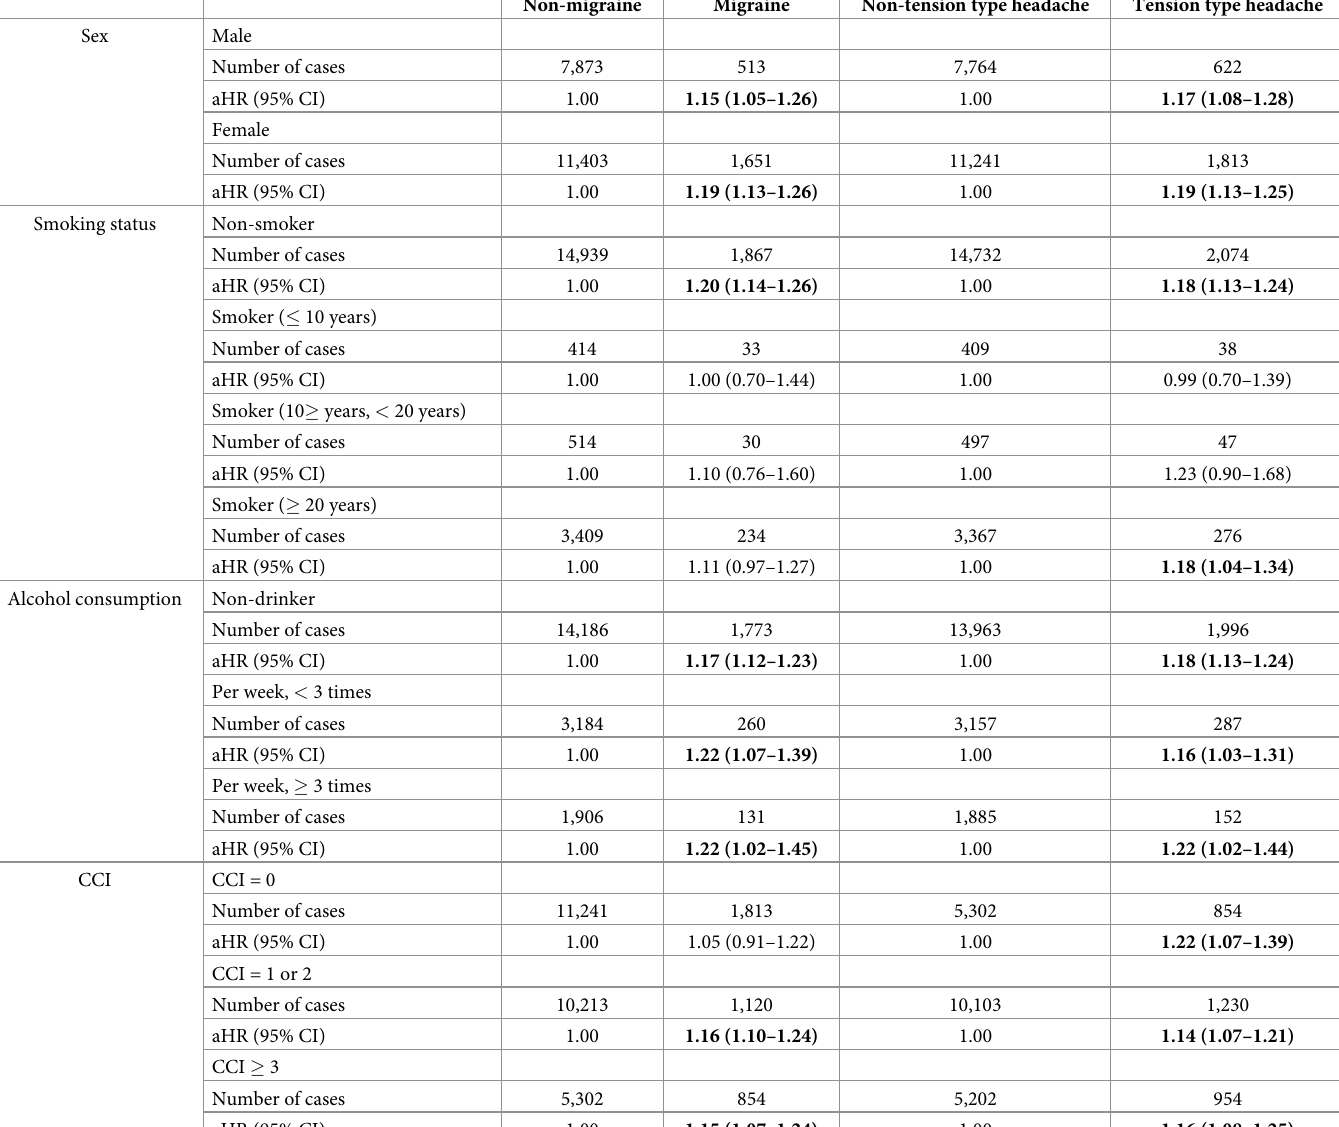
Table 3. Subgroup analysis of associations between headaches and the risk of all cause